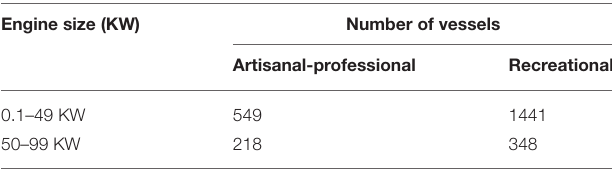
TABLE 2 | The recreational vessels (MFC) 4 outnumber the amount of artisanal-professional vessels in the smaller-engine cohorts, thereby demonstrating the intense and one-sided competition posed by the recreational sector on the artisanal counterpart (Data provided by national